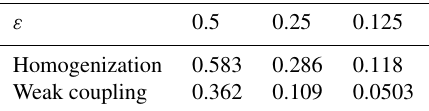
Table 4. The relative error on the standard deviation of the exit of exit times from [− 1 , 1 ] of the full triad system of Eq. (21) and σ 1 (τ) is the standard deviation of exit times of the parameterized systems of Eqs. (22) and (27). The parameters are the same as those used for Fig. 3. These values are calculated from 1000 independent